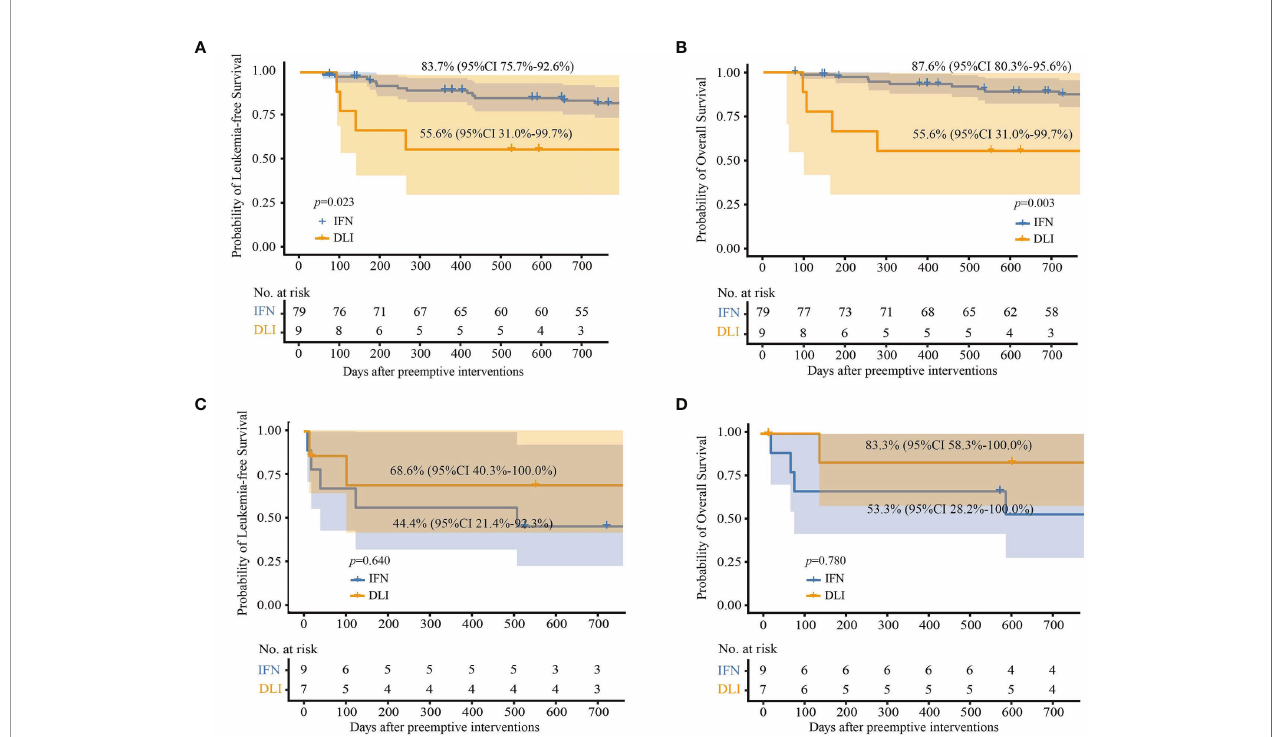
FIGURE 3 | Probabilities of survival at 2 years after preemptive immunotherapies in full analysis set. (A) Leukemia-free survival in patients with low- and intermediate- level RUNX1-RUNX1T1 ; (B) overall survival in patients with low- and intermediate-level RUNX1-RUNX1T1 ; (C) leukemia-free survival in patients with high-level RUNX1-RUNX1T1 ; (D) overall survival in patients with high-level RUNX1-RUNX1T1